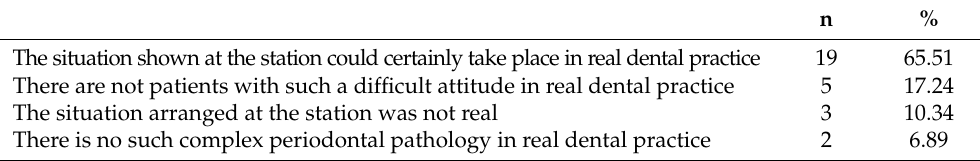
Table 5. Answers to question 3. What of the possible methodology to be used in the OSCE do